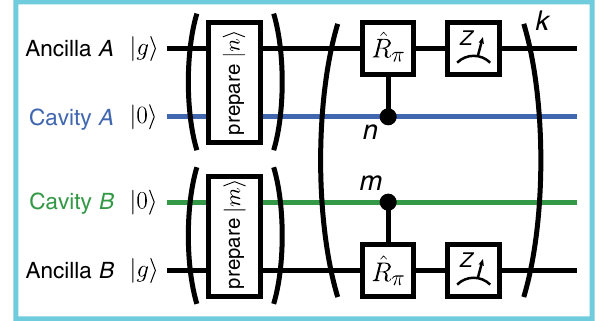
FIG. 8. Circuit implementation of heralded state preparation.